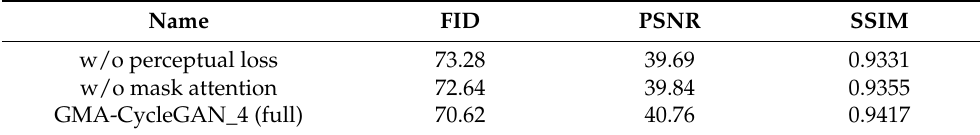
Table 3. Results of different ablation studies for GMA-CycleGAN_4.